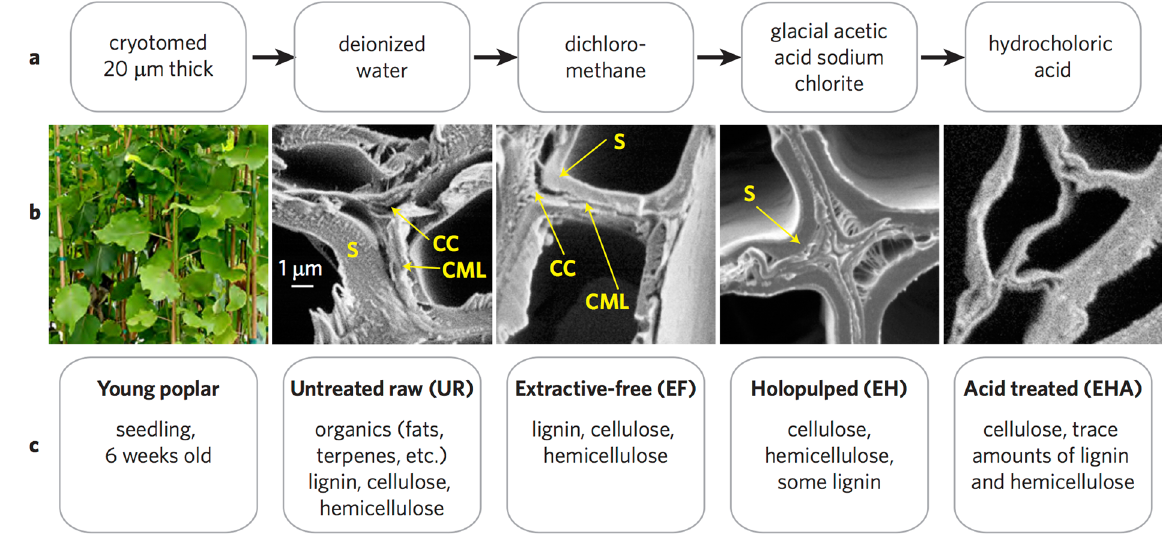
Figure 1. The sequence of chemical treatments for exploring the effect of lignin loss. ( a ) The sequence commences with untreated raw (UR) samples. Extractive-free (EF) samples are prepared by refluxing UR samples with dichloromethane followed by treatment with glacial acetic acid and sodium chlorite. The acid treatment (EHA), following the extractive-free holopulped (EH) samples completes the sequence. ( b ) The investigated plant species and the scanning electron microscope images (5000X magnification) of the samples at each stage of the chemical processing. ( c ) Annotation of the lignocellulosic content corresponding to UR, EF, EH, and EHA. See the supplementary